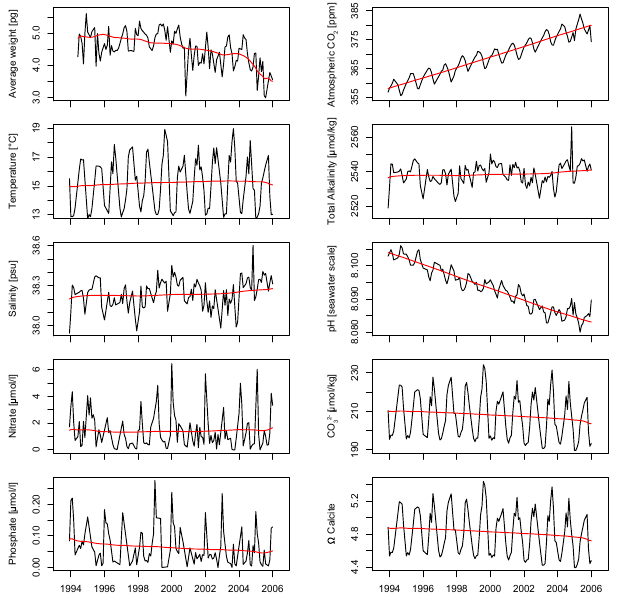
Figure 8. Long-term trends in the environmental data from single spectrum analysis (SSA). Black lines show the evenly spaced data set produced from the environmental measurements (see methods). Red lines indicate the trends from the SSA.